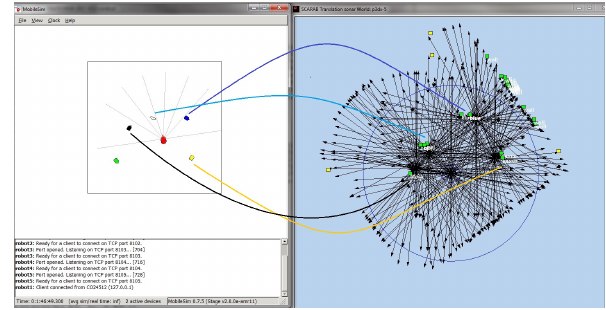
Figure 7: Sonar map from use of SCARAB control of Pioneer 3- DX in mobilesim. Colour coded arcs represent a mapping from objects located to their position in the simulator. The sonar map is rotated as it reflects the orientation of the robot at the start of the simulation run.